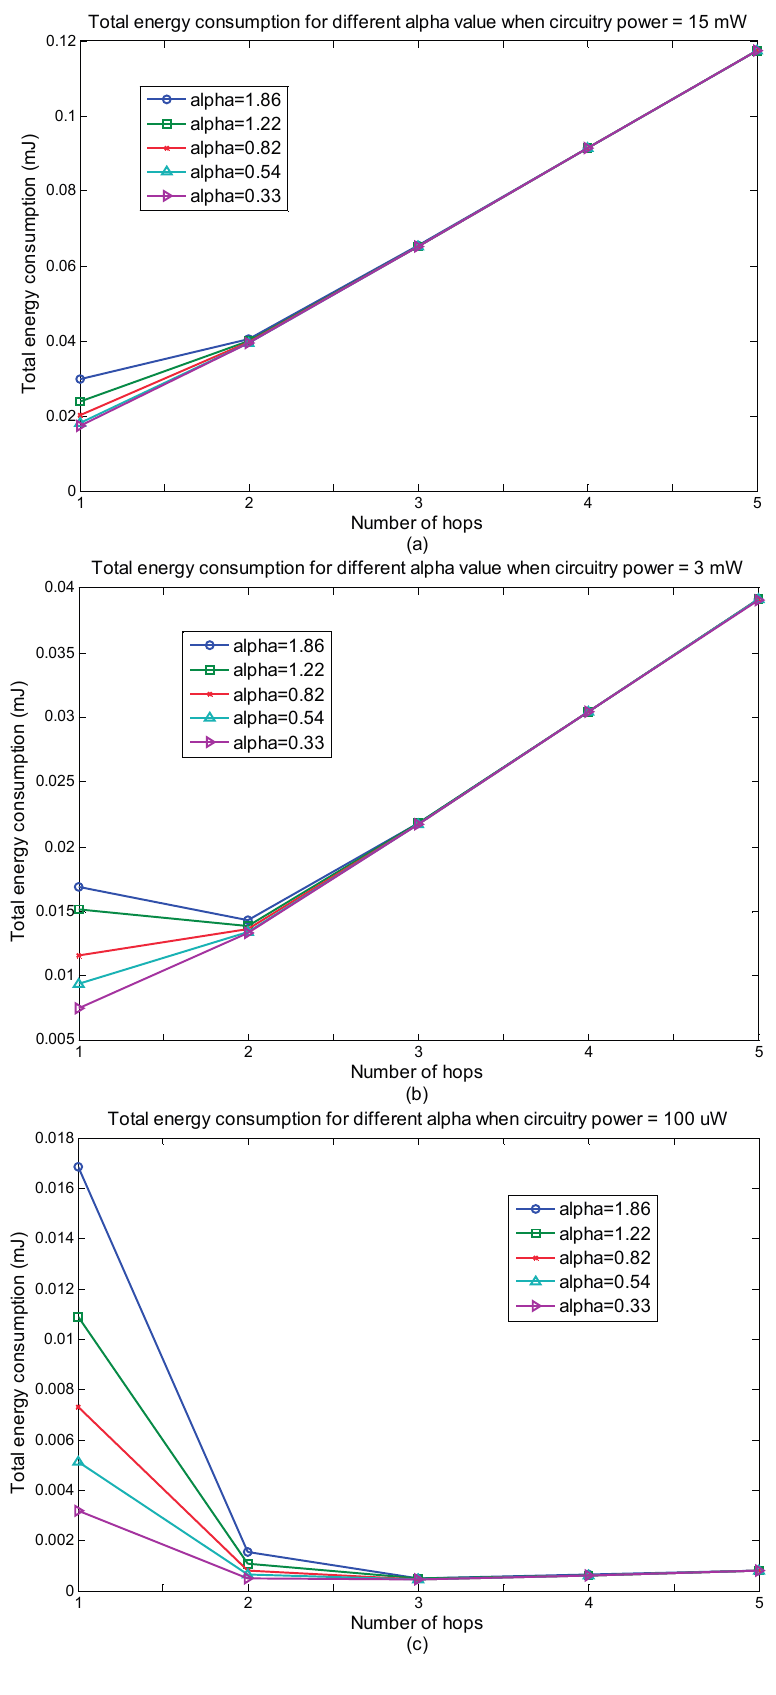
Figure 3. Energy consumption vs . number of hops for different α when circuitry power is equal to ( a ) 15 mW; ( b ) 3 mW; ( c ) 100